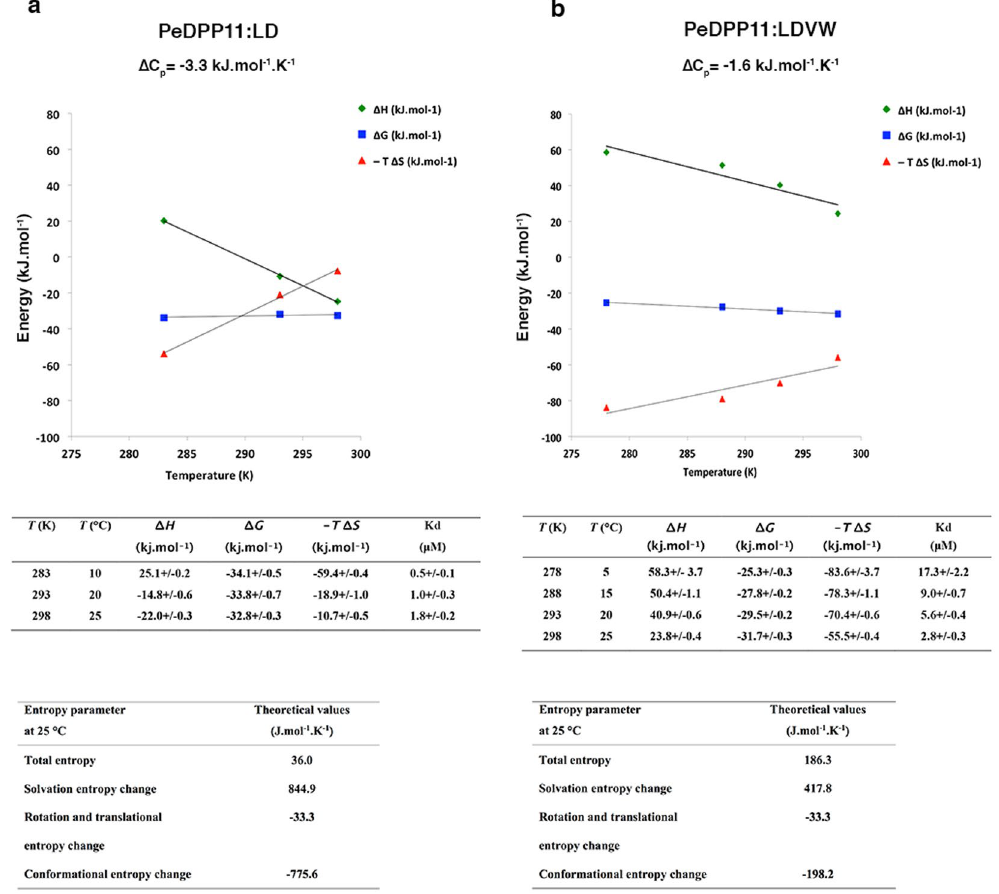
Figure 3. Thermodynamic analysis. (a) PeDPP11 binding to LD. (b) PeDPP11 binding to LDVW. Upper panels: Temperature dependence of ∆ G , ∆ H and − T ∆ S. Middle panel: Table with thermodynamic data derived from the ITC measurements at different temperatures. Lower panel: Entropy parameters estimations. Conformational entropy was calculated using the following equation: ∆ S conf = ∆ S tot − ∆ S sol − ∆ S rt34 . Where ∆ S sol = ∆ Cp ln (298 K/385 K) 65 and ∆ S rt is estimated using the “cratic entropy” value of − 33.3 J.mol. − 1 K − 1 66